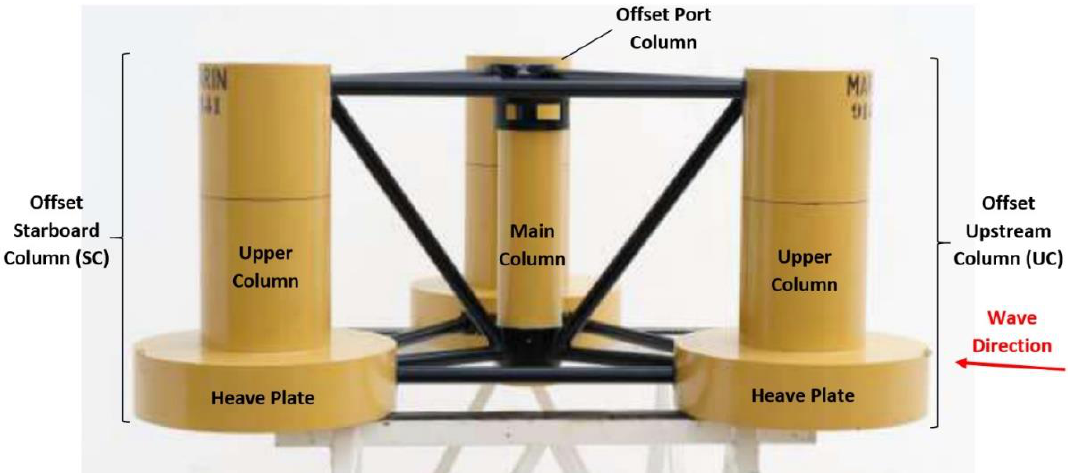
Figure 4. The DeepCwind floating semisubmersible design [17]. Photo adapted with permission from the University of Maine.